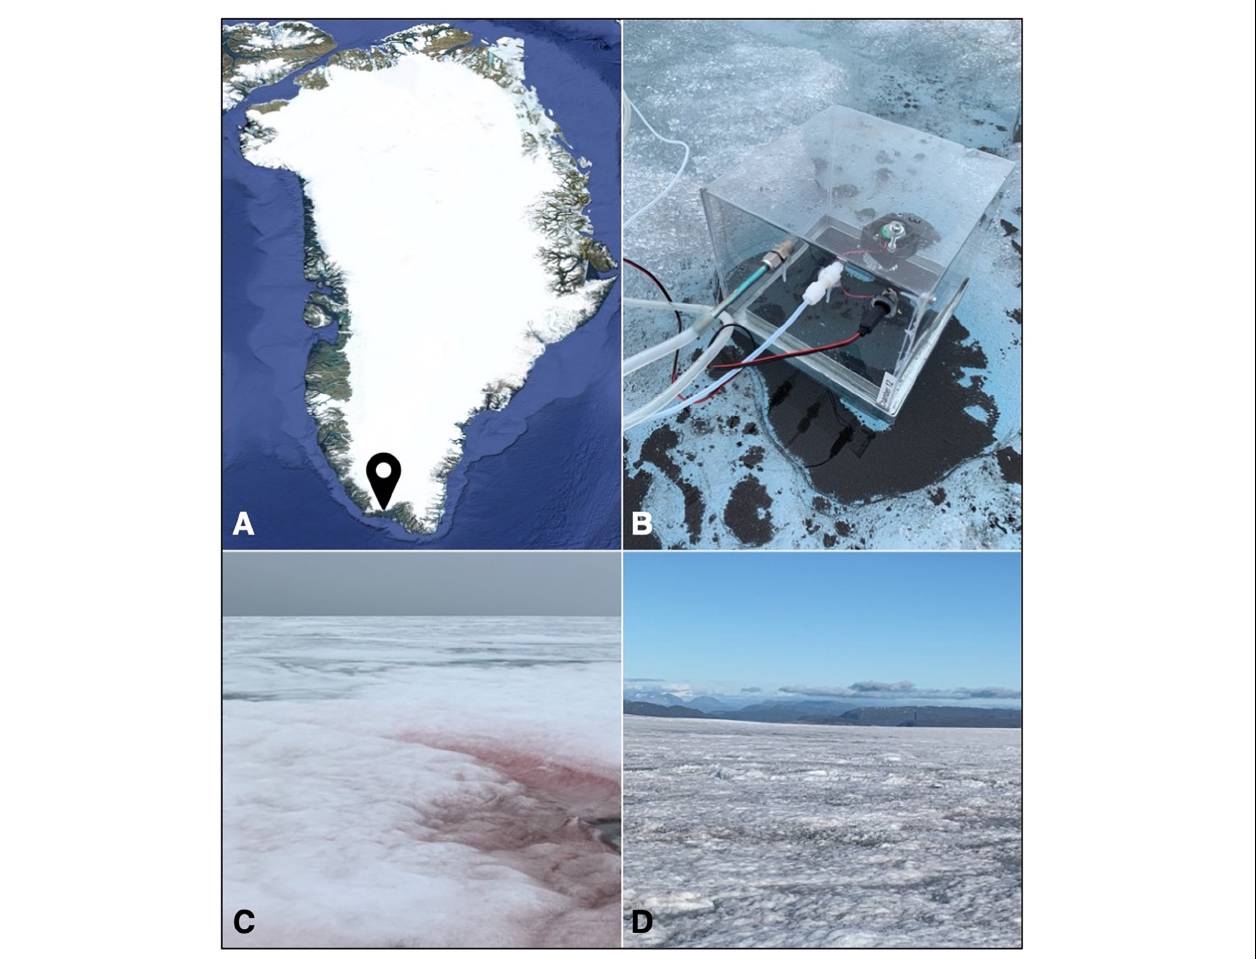
FIGURE 1 | (A) Map of Greenland showing the location of the 2020 field site; (B) the sampling setup used in this study, with the sorbent tube for sample collection (left), the air inlet (middle) and the power supply for the internal fan (right), and the chamber base placed in a large cryoconite hole; (C) a red snow patch at the start of the sampling campaign; and (D) bare ice surface colonized by algal